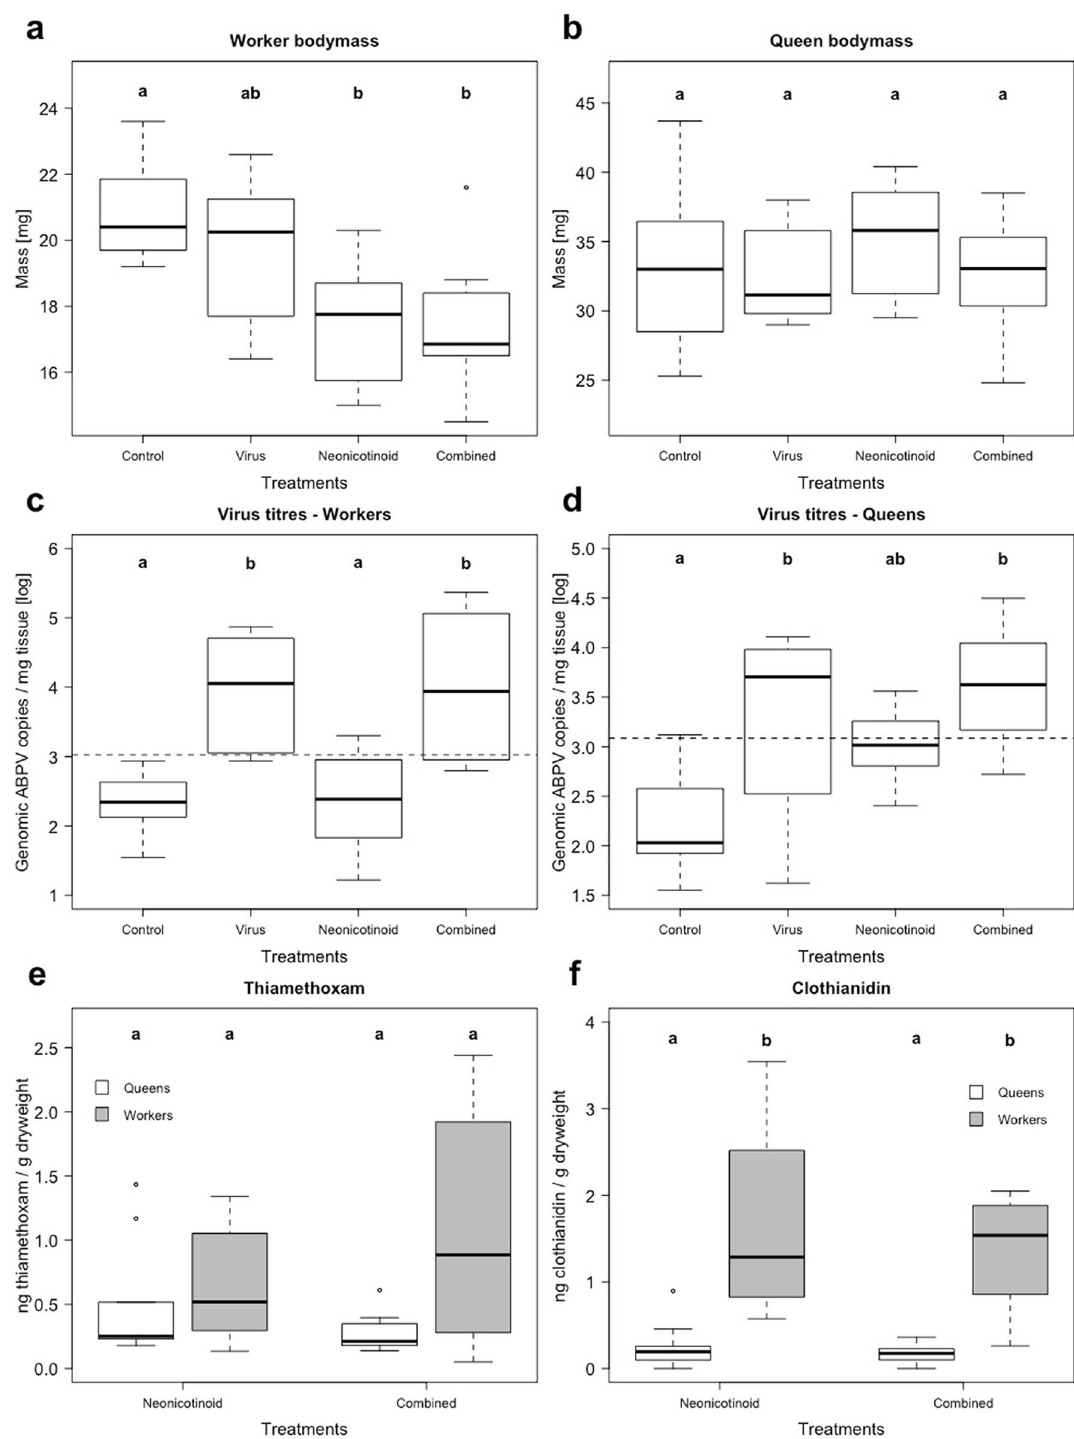
Figure 1. Body mass, virus titres and neonicotinoid residues of queens and workers, Lasius niger. Body mass (mg) of 20 pooled workers ( a ) and queens ( b ) as well as genomic copies of Acute bee paralysis virus (ABPV) [log] per mg tissue of workers ( c ) and queens ( d ) under the following four treatments groups: Controls, neonicotinoid = chronic exposure to thiamethoxam (30 ppb), virus = feeding regime with ABPV and combined = exposure to both thiamethoxam and ABPV. Neonicotinoid residues [ng/g dry mass] of queens (white boxplots) and workers (grey boxplots) in the neonicotinoid and combined treatment are depicted in panels ( e ) for thiamethoxam and ( f ) for clothianidin. Boxplots with inter-quartile-ranges, medians and outliers as well as the virus detection thresholds for both castes (dashed line) are shown as well as significant differences (p < 0.05) between treatments, which are indicated by bold letters (Tukey post hoc